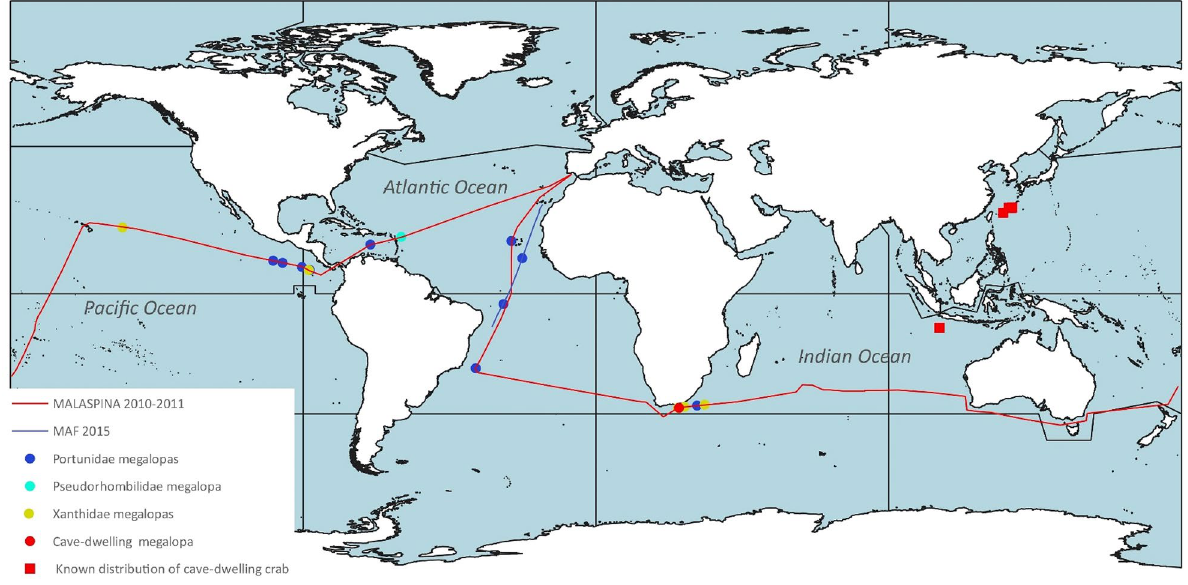
Figure 1. Map of megalopa samples taken and cruise tracks during the MALASPINA 2010–2011 and MAF 2015 expeditions, and the known distribution of the cave-dwelling crab, Neoliomera cerasinus .